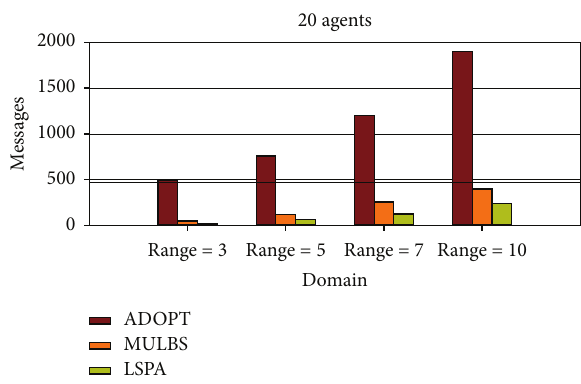
Figure 14: Messages with density 3 and domains 2, 5, 7, and